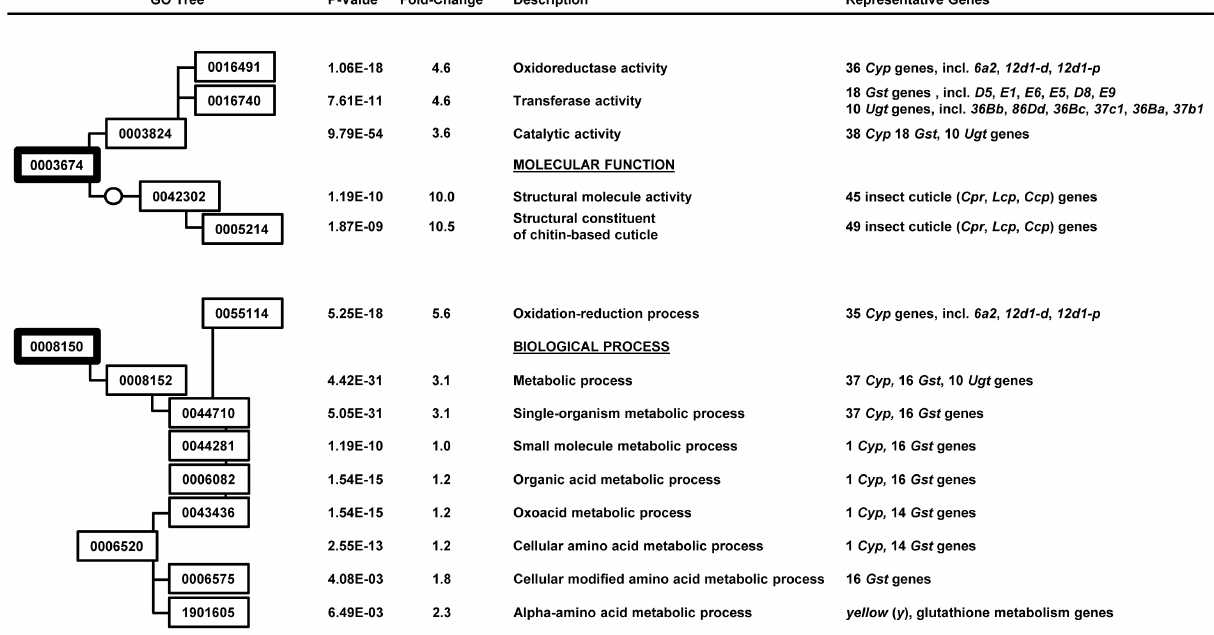
Figure 4. Gene ontology enrichment analysis for Ama-KTT/M/2 versus Canton-S on no toxin (group 2 versus 1). The GO trees for the molecular function and biological process are shown on the left-hand side with the numbers for each term. The corrected p-values, average fold- changes for all genes in each term, term names, and selected genes of each GO term are shown on the right-hand side of each term number.